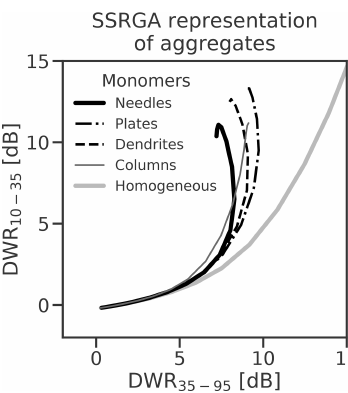
Figure 2. Triple-frequency radar signatures for SSRGA represen- tations of four aggregates of different monomers (Table 1) and a representation of homogeneous particles ( β = 4).